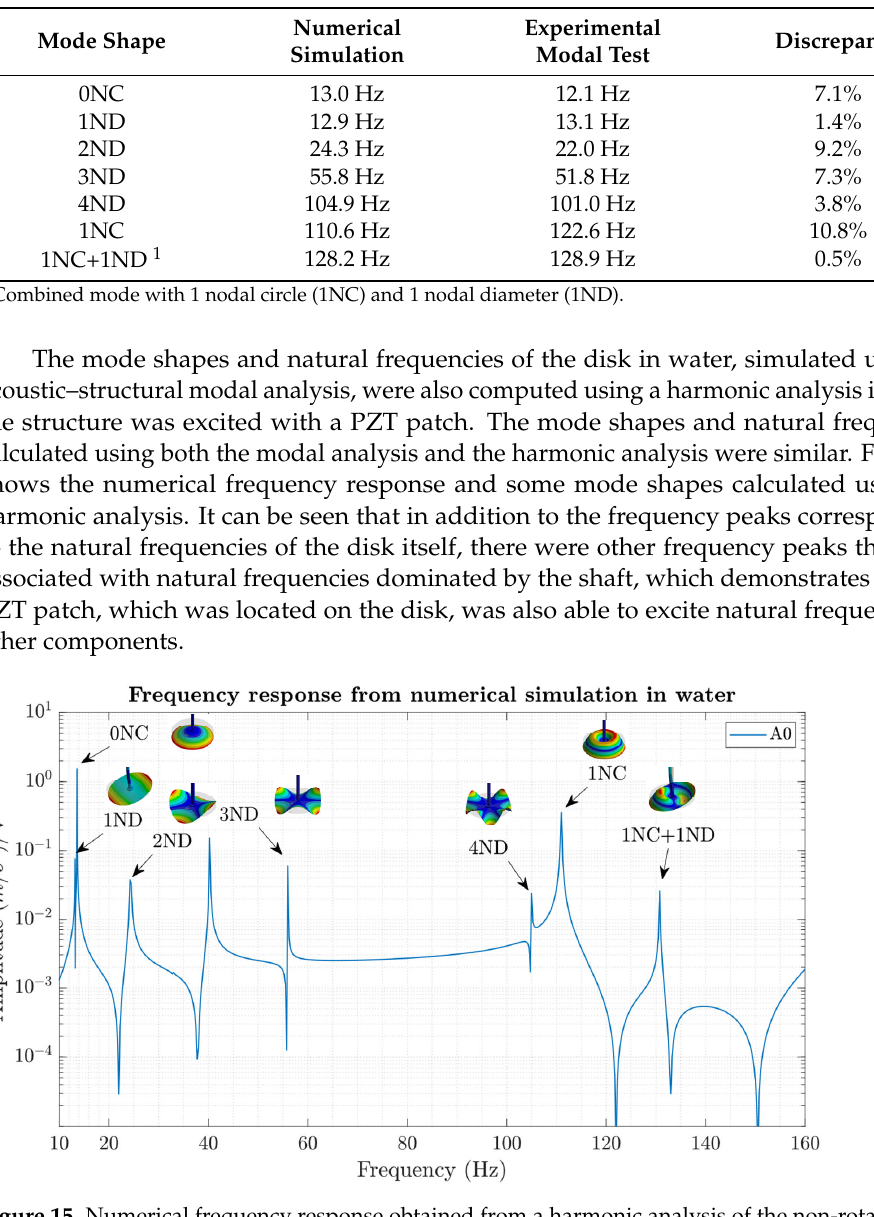
Figure 16. Maximum normalized spectra of the STFT measured from several sensors when the disk (non ‐ rotating and rotating) was excited with a chirp in the range of 0–100 Hz in water.